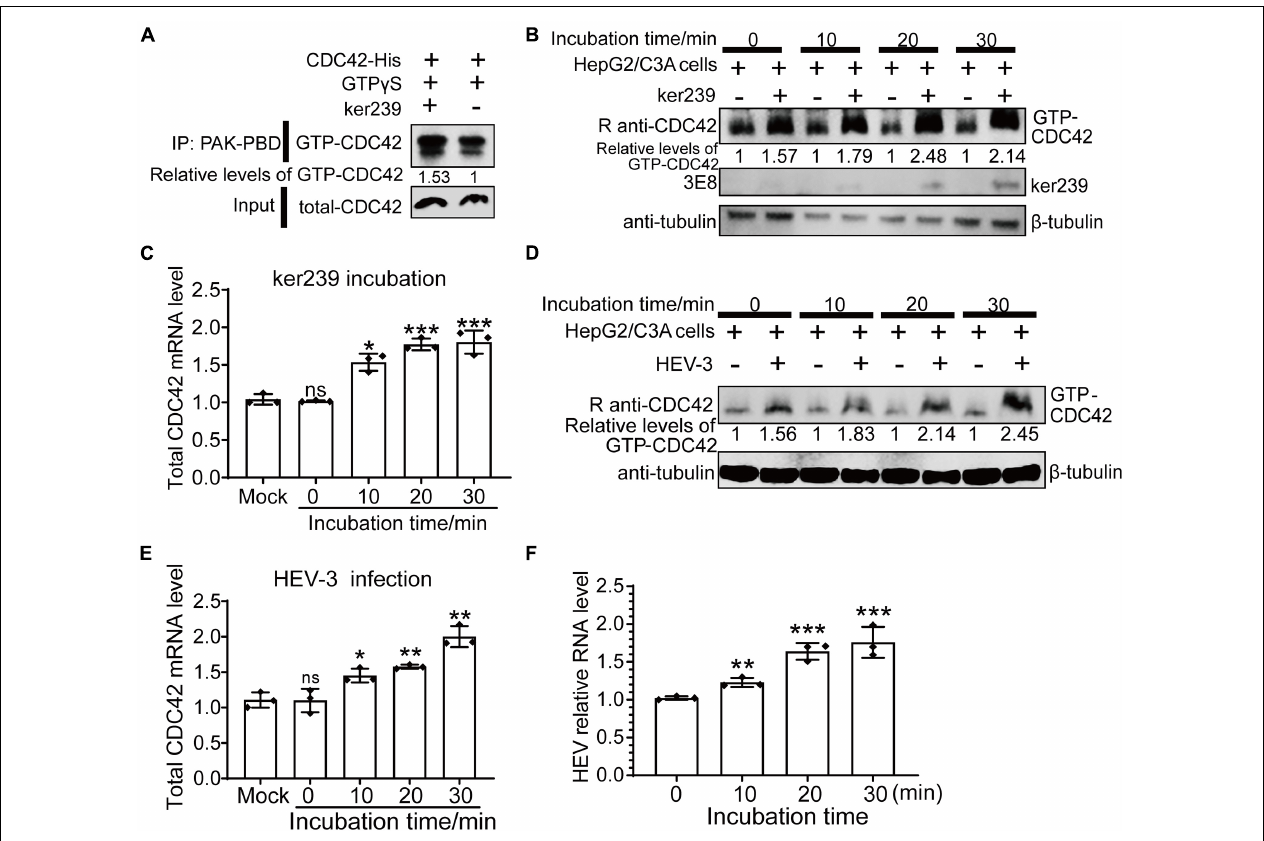
FIGURE 6 | Upregulation of expression levels of GTP-CDC42 and total CDC42 in ker239 treated and non-enveloped HEV infected cells. (A) CDC42 binding more GTPs through interaction with ker239 in vitro . (B) Expression levels of GTP-CDC42 in HepG2/C3A cells treated with ker239 at 0, 10, 20, and 30 min. (C) Total mRNA levels of CDC42 in HepG2/C3A cells treated with ker239 by qPCR. (D) Expression levels of GTP-CDC42 in HepG2/C3A cells inoculated with naked HEV-3 at 0, 10, 20, and 30 min-post-inoculation. (E,F) The mRNA levels of total CDC42 (E) and HEV-3 RNA (F) in HepG2/C3A cells inoculated with HEV-3 by qPCR. RNA levels were normalized to human GAPDH. ns, no significant; * P < 0.05; ** P < 0.01; *** P <